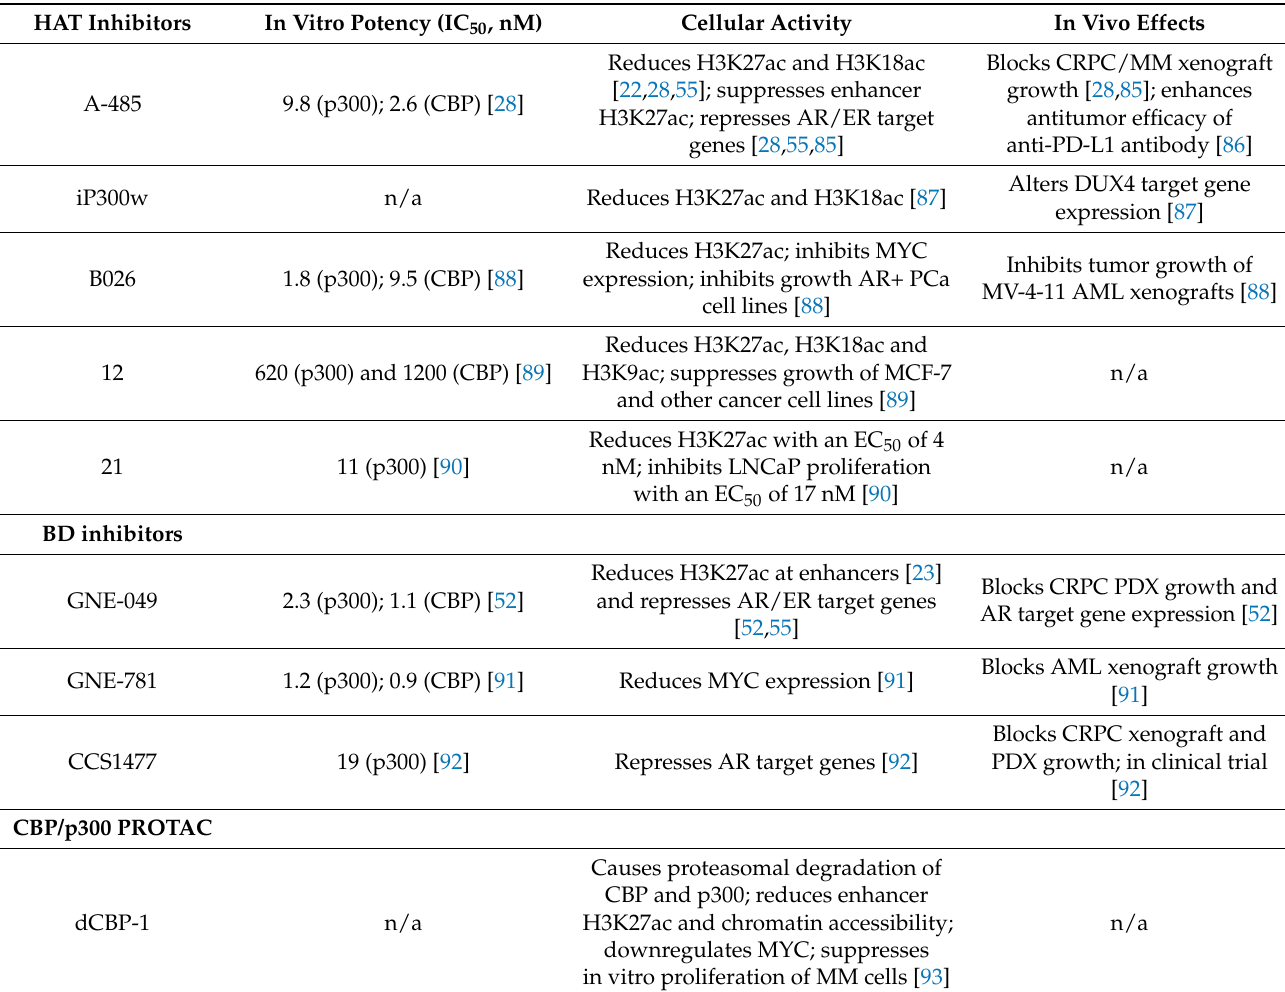
Table 2. CBP/p300 inhibitors